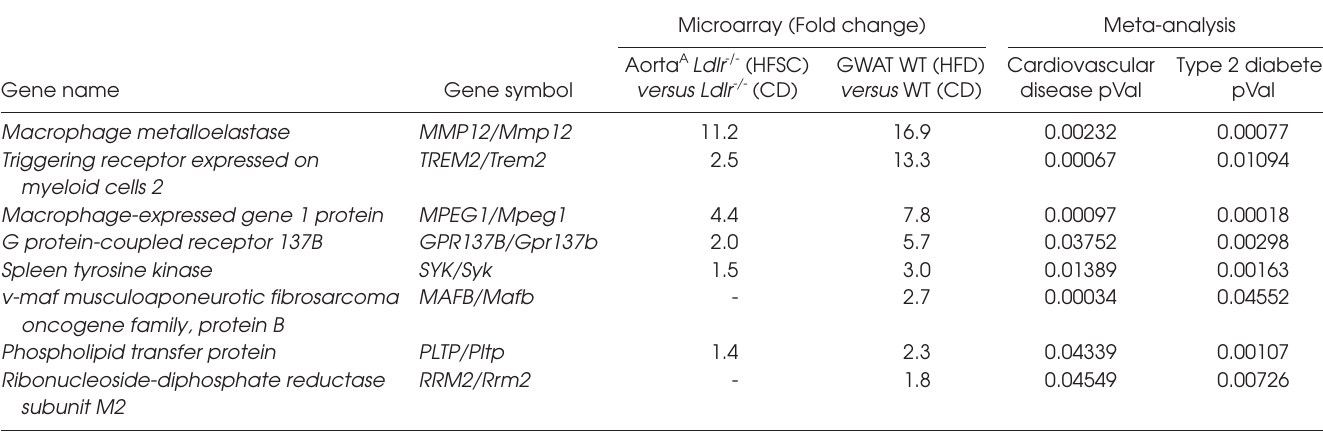
Table 2. List of the eight candidate genes ordered by the expression in the GWAT microarray selected as potential new targets. Microarray (Fold